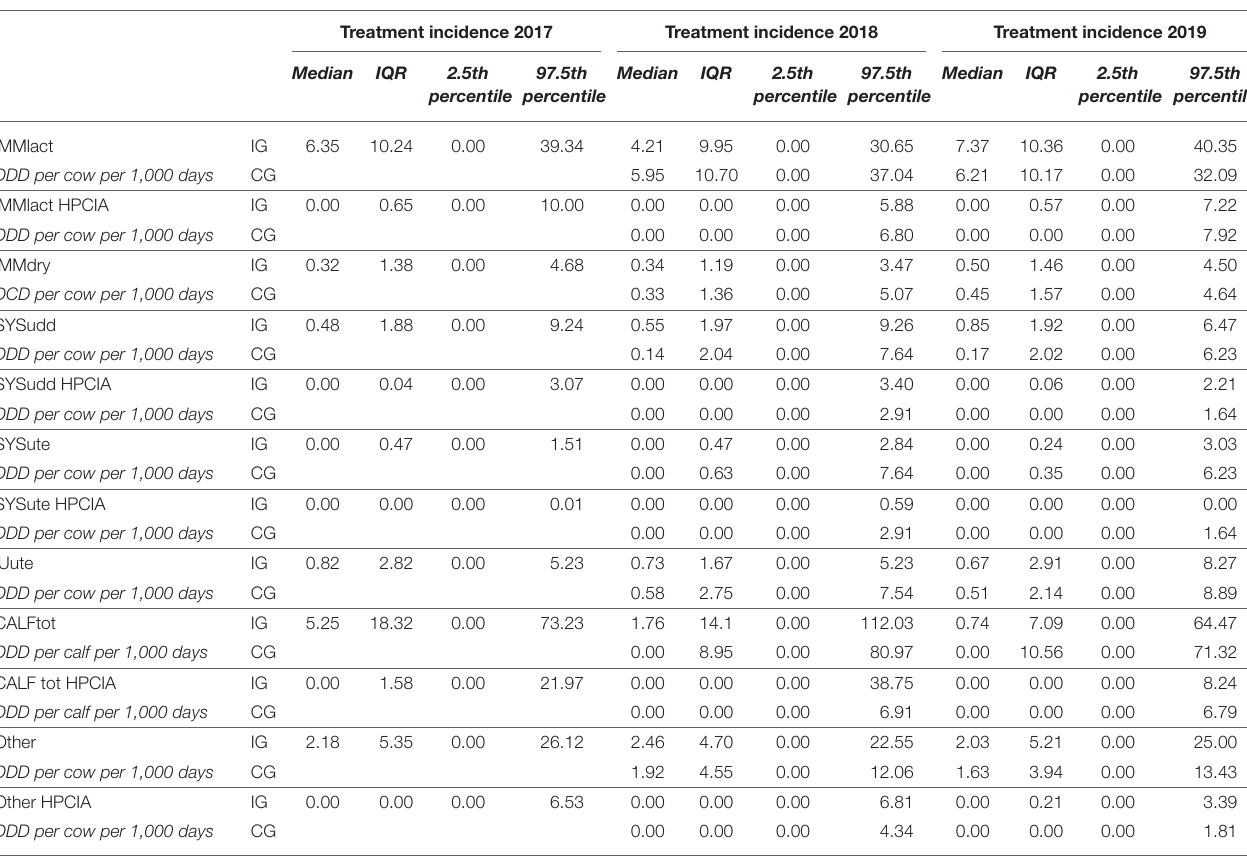
TABLE 4 | Treatment incidence per group (median, interquartile range, 2.5th percentile, 97.5th percentile) of antimicrobials for the intervention group and the control